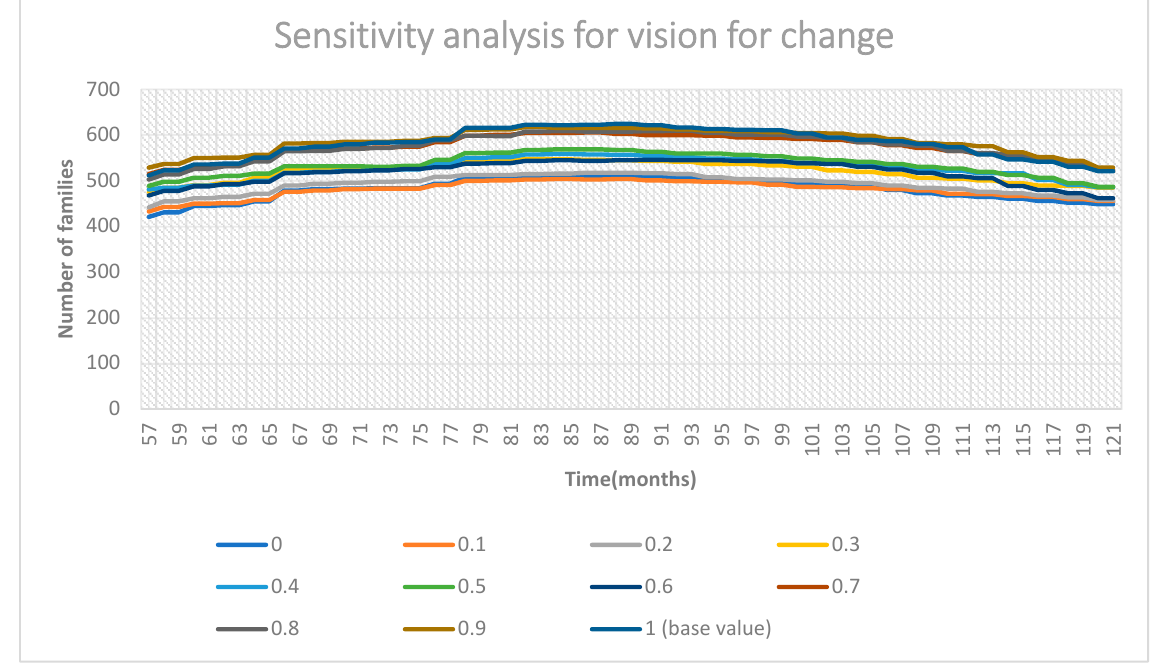
Figure 7. The effect of different weights of vision for change on transformation outcomes.